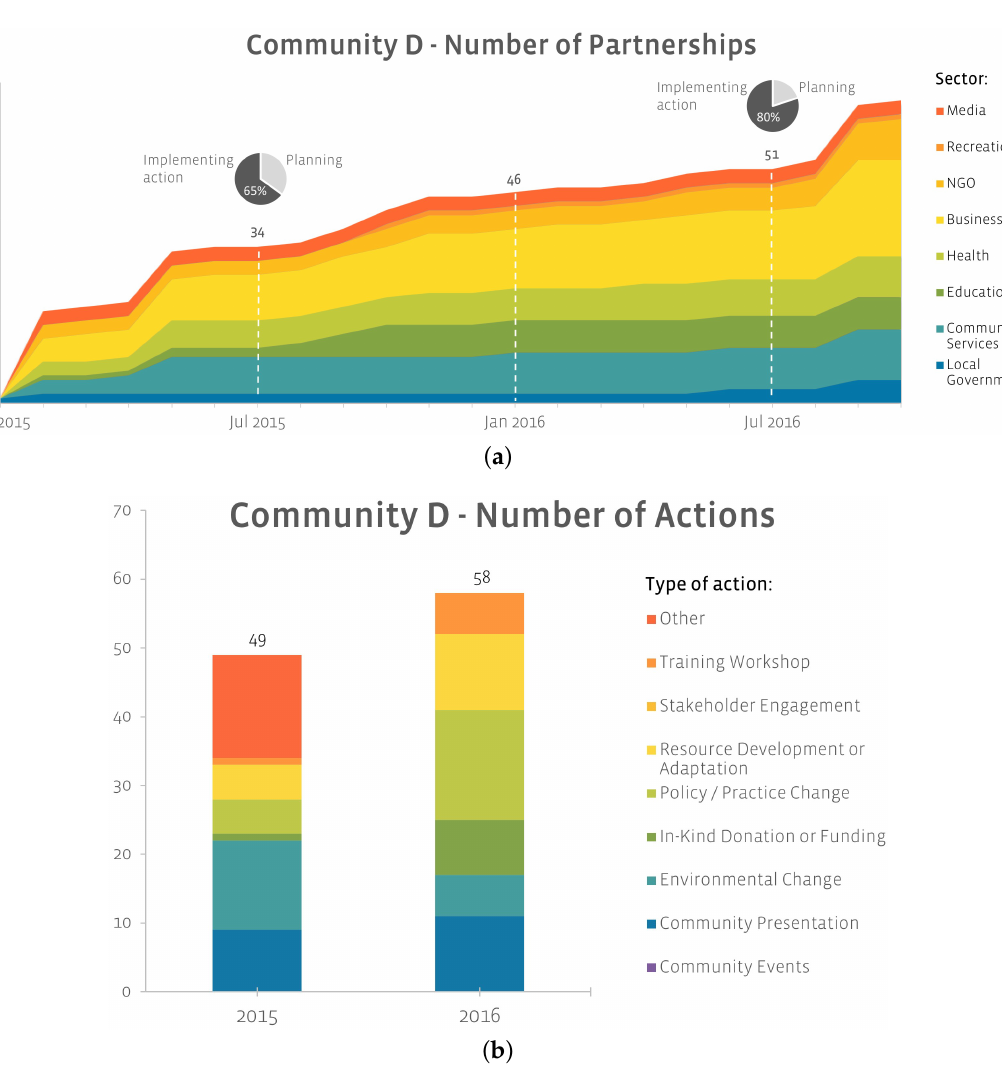
Figure 2. Live 5-2-1-0 Partnership Formation, Growth, and Action in ‘New’ Communities. ( a ) The formation and growth of multi-sectoral community partnerships in Community D (new) using the PTT. ( b ) Actions implemented by Community D (new) over the study